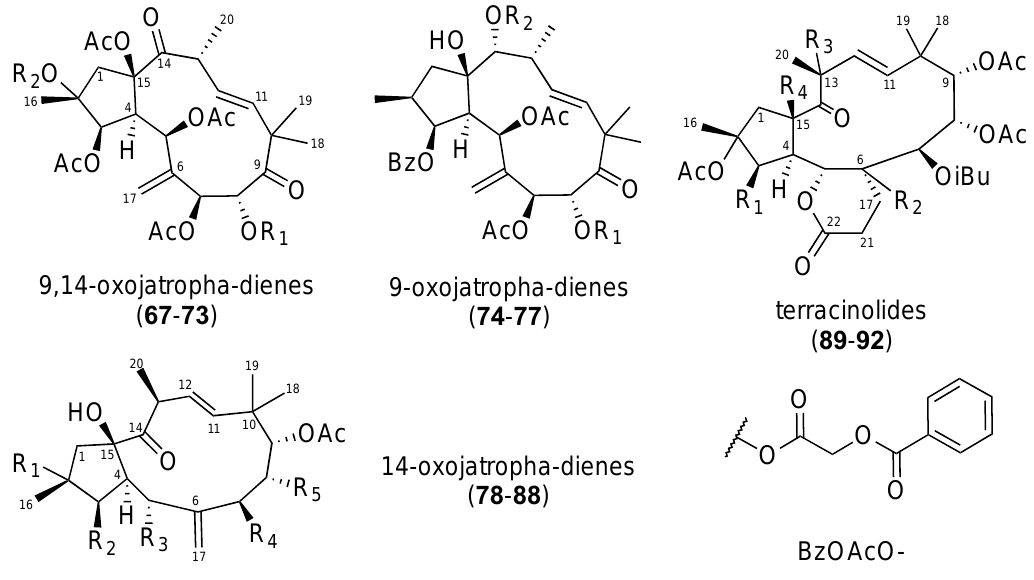
Figure 4. Structures of jatrophanes 67 – 92 .